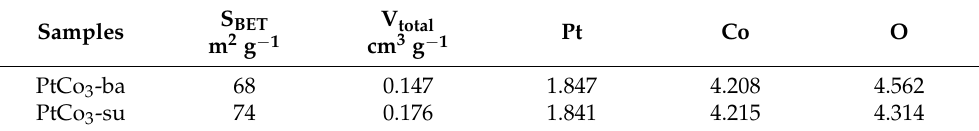
Table 2. Structural properties and elemental compositions of